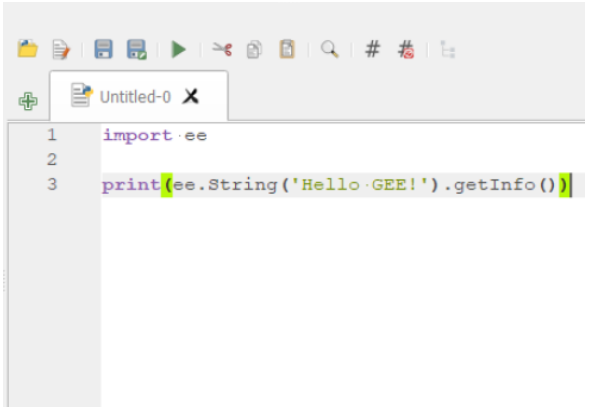
Figure 4. Initialisation of GEE connection in the Python console